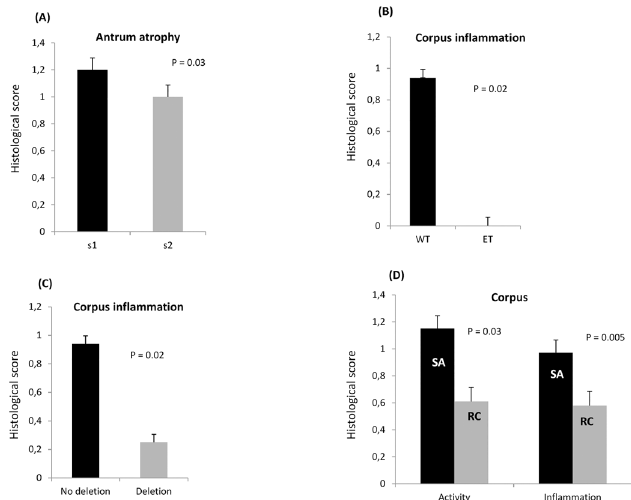
Fig 1. The association of histological findings and genotypes in Helicobacter pylori Nepalese strains. (A) The vacA s1 genotype had significantly greater antrum mucosal atrophy than the vacA s2 genotype. Inflammation in the corpus was more highly associated with the Western-type- cagA than East-Asian-type- cagA type (B), and with the non-deletion type than the deletion type (C). The specific South Asian genotype had higher levels of activity and inflammation in the corpus than the recombination genotype